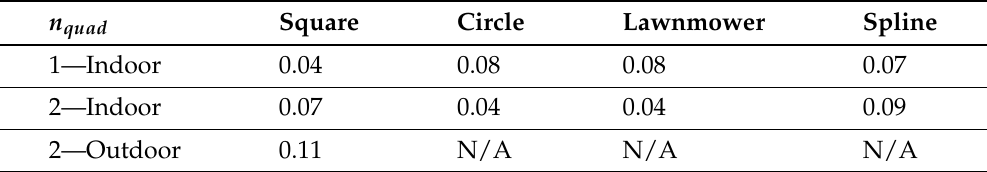
Table 3. Boundary violation rate O results for each flight test path